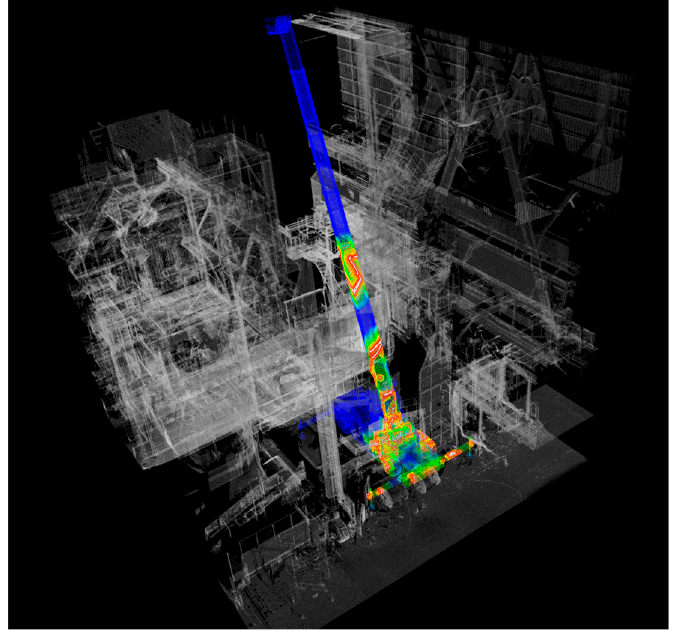
Figure 18. Transparent visualization of the crane vehicle that collides with the plant. The total number of points that is used for the visualization is 1.01 × 10 7 .